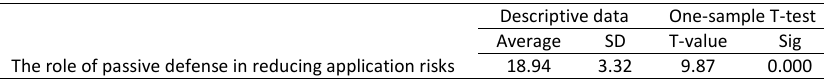
Table 3: Descriptive data and significance analysis of passive defense impact on reducing application risks Descriptive